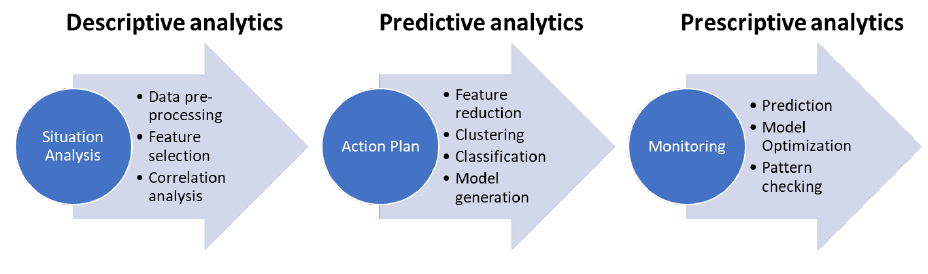
Figure 2. Data-Informed Policymaking process.